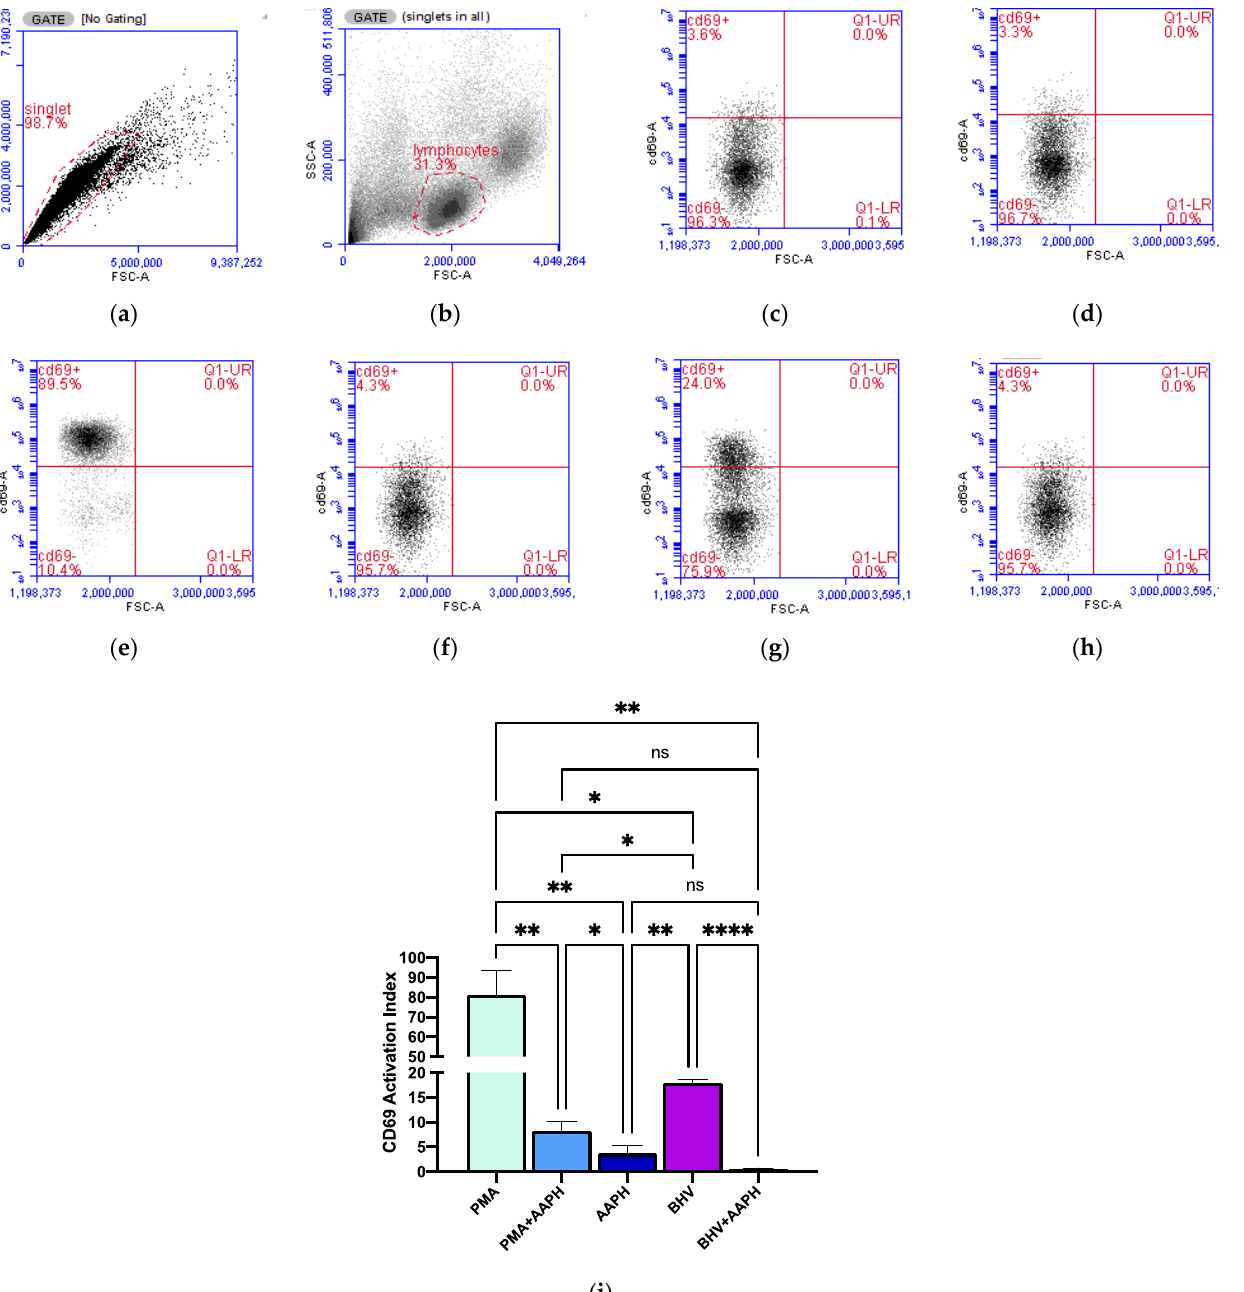
Figure 6. Flow cytometry analysis of lymphocyte populations from isolated peripheral mononuclear blood cells (PBMCs). ( a ). Gating strategy for singlets. ( b ) Gating strategy for lymphocytes based on forward scatter (FSC-A) and side scatter (SSC-A) characteristics. ( c ) CD69+ expression in untreated PBMCs, on the X axis FSC-A indicating cell size and on the Y axis the evaluated CD69 dye. ( d ) CD69 expression under 2,2 ′ -Azobis(2-amidinopropane) dihydrochloride (AAPH) treat- ment. ( e ) CD69 expression under 10 ng/mL phorbol 12-myristate 13-acetate (PMA) treatment. ( f ) CD69 expression under